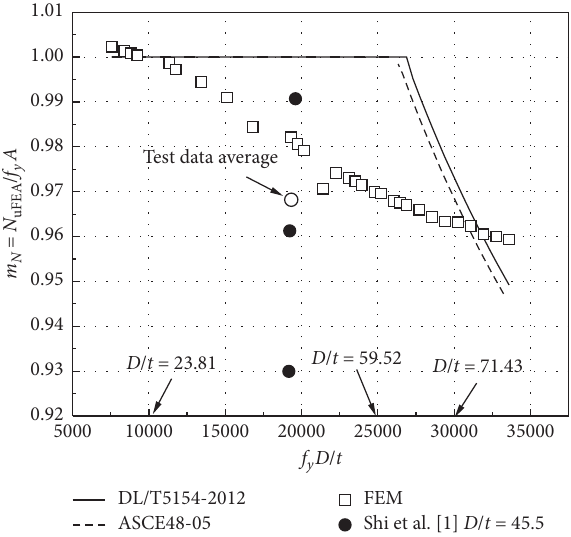
Figure 18: Strength reduction factor mn versus fyD / t